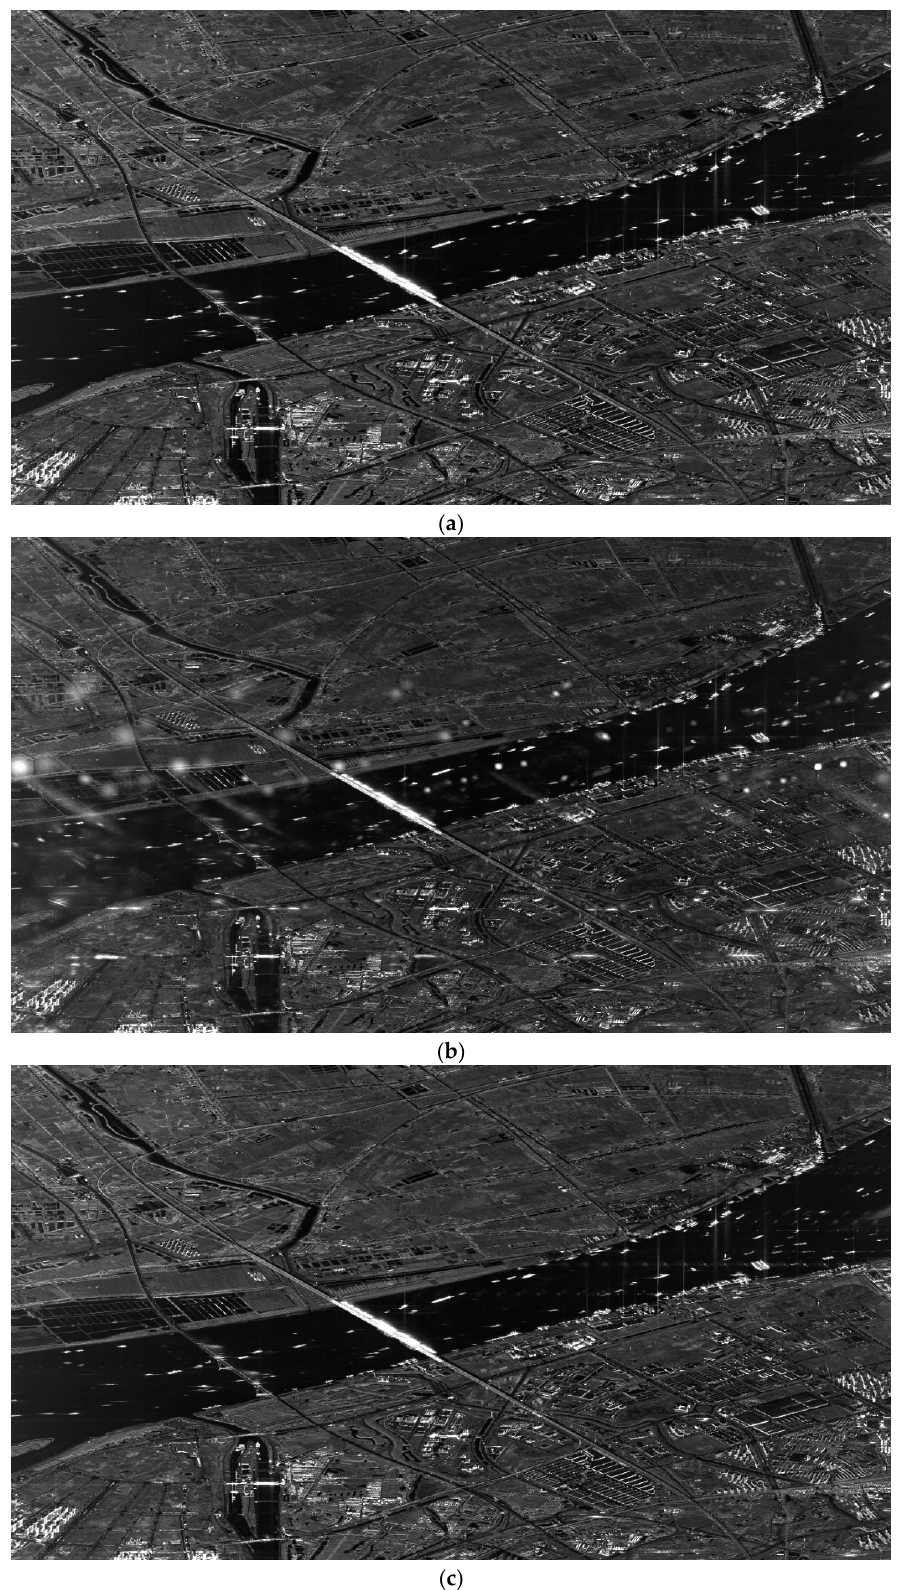
Figure 6. Experiments on GF-3 data. ( a ) Result of conventional two-step processing approach without data-preprocessing. ( b ) Result of conventional two-step processing approach with data-preprocessing. ( c ) Result of modified two-step processing approach (based on modified sinc interpolation) with data-preprocessing.